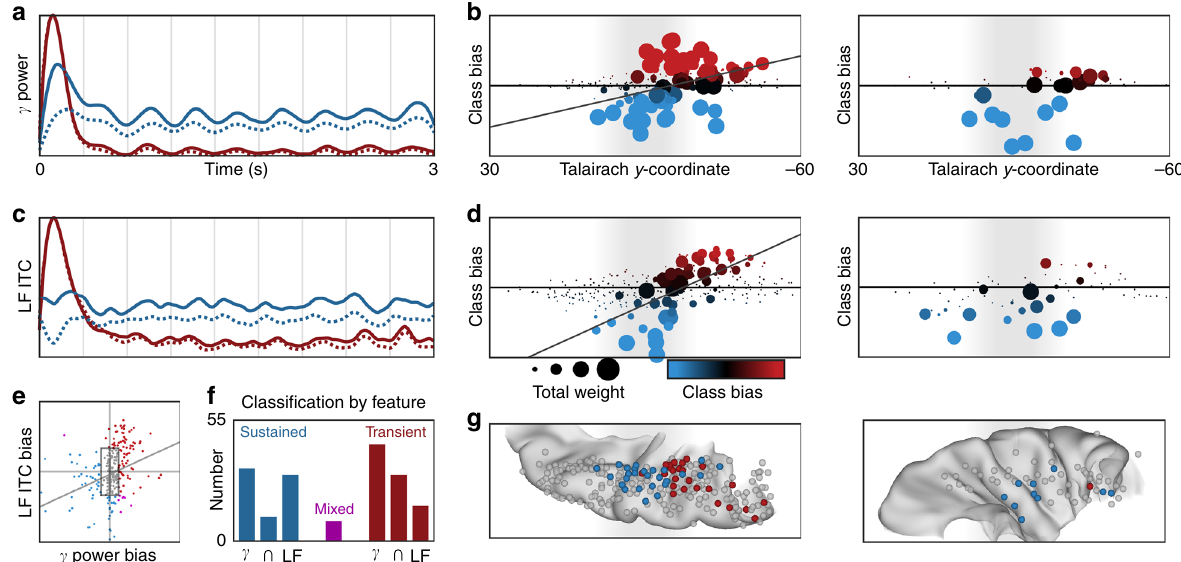
Fig. 6 Supratemporal distribution of sustained and transient responses to white noise. Supratemporal responses ( n = 349 electrodes) classi fi ed with two-basis non-negative matrix factorization. a High-gamma power identi fi es a sustained (blue) and transient (red) response: normalized basis functions (dotted line) and the normalized group-average response for the top 10% of electrodes in each class (solid line). b Spatial distribution of activation (sum of class weights; point size) and bias (difference in class weights; point color) reveals anteroposterior gradient of functional response. The left panel shows electrodes in language-dominant cortex; the right, in language non-dominant cortex. c , d Separately, low-frequency ITC also revealed sustained and transient responses with the same spatial distribution. e The class bias determined by high-gamma power and low-frequency ITC analyses were signi fi cantly correlated. f Class biases greater than a value of 10 generated discrete classi fi cations: sustained ( n = 74), transient ( n = 90), or mixed ( n = 9). g Electrode classi fi cations are shown on a standard supratemporal atlas, demonstrating a clear functional split between Heschl ’ s gyrus and planum temporale in language-dominant power (Fig. 6b; r s = 0.4101, p < 10 − 4 ) and low-frequency phase (Fig. 6d; r s = 0.7356, p < 10 − 16 ). Classi fi cation by both measures were strongly correlated (Fig. 6e; r s = 0.4188, p < 10 − 6 ); only 9 of